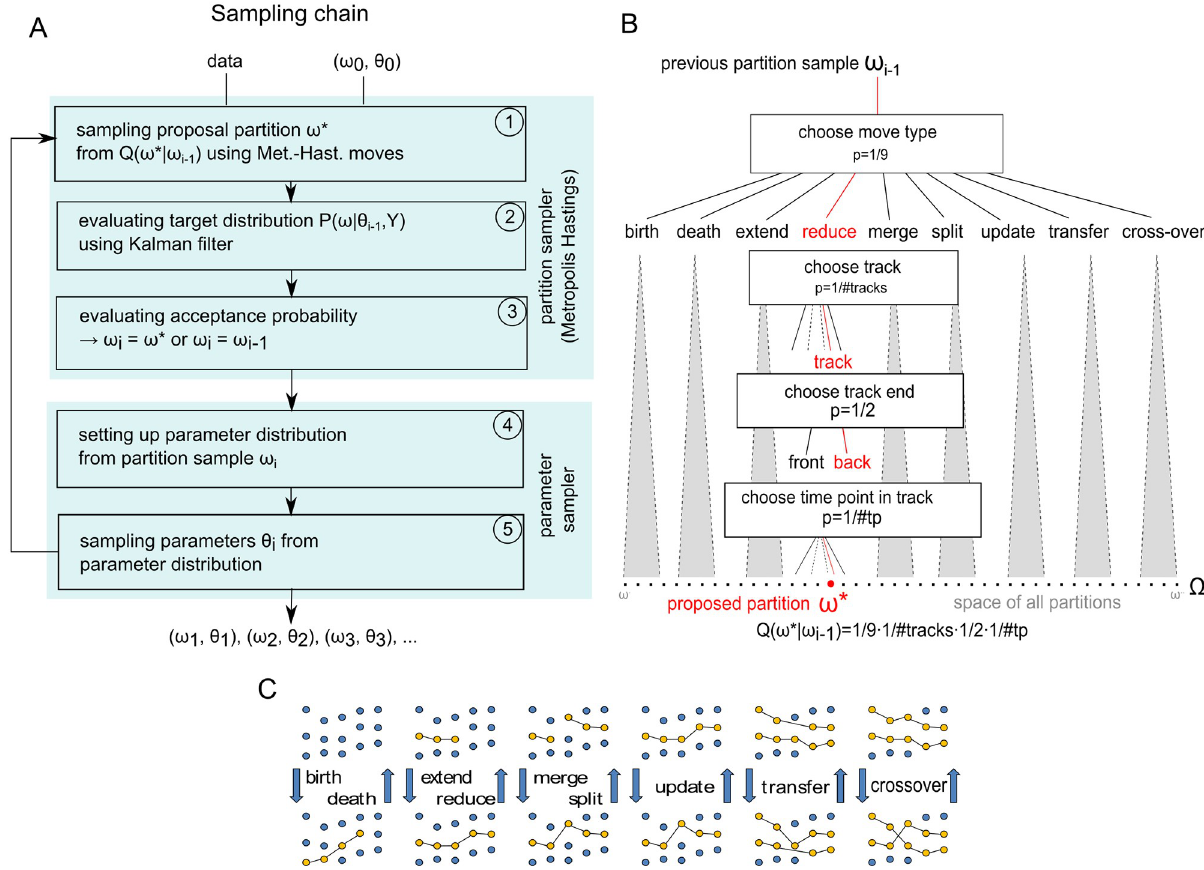
Fig 1. Algorithm overview. A) Biggles runs two sampling chains with different initial partitions ω 0 . Each chain is a Gibbs sampler alternately sampling partitions, steps ① - ③ , and parameters, steps ④ - ⑤ . B) Schematic of sampling and evaluating the proposal distribution Q ( ω � | ω i − 1 ), step ① in panel A. The sampling is realised by descending a sampling tree; the root of the tree is the current partition ω and the leaves are the partitions ω � that can be i − 1 reached, i.e. where Q ( ω � | ω i − 1 ) > 0. Each branch has a certain probability given the parent branch, so that the probability of a leaf is the product of the probabilities of the branches traversed during the descent. A descent down the reduce move branch is sketched. Other move types are executed in a similar manner, but with different branching operations. C) Cartoon of the move type pairs. Each move type has a positive probability to undo any modification of its partner, i.e. Q ( ω � | ω i − 1 ) > 0 if and only if Q ( ω i − 1 | ω � ) > 0. D) Cartoon of the observation likelihood calculation in step ② in panel A, using the update move example of panel C. The Kalman filter estimates the particle states (black dots) of the track model; the red line illustrates a possible course. The likelihood of the observations assigned to the track (yellow) is calculated using the filter’s observation model. The change in the track assignment by the update move leads to different state estimates and hence to different observation likelihoods. For full details see Supplementary